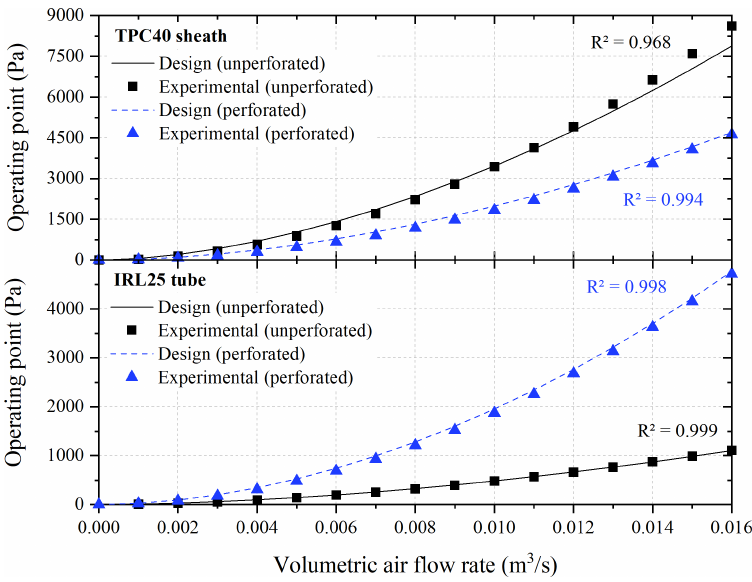
Figure 5. Evolution of the network pressure operating point, according to the volumetric air flow rate for the for aeraulic configurations tested.